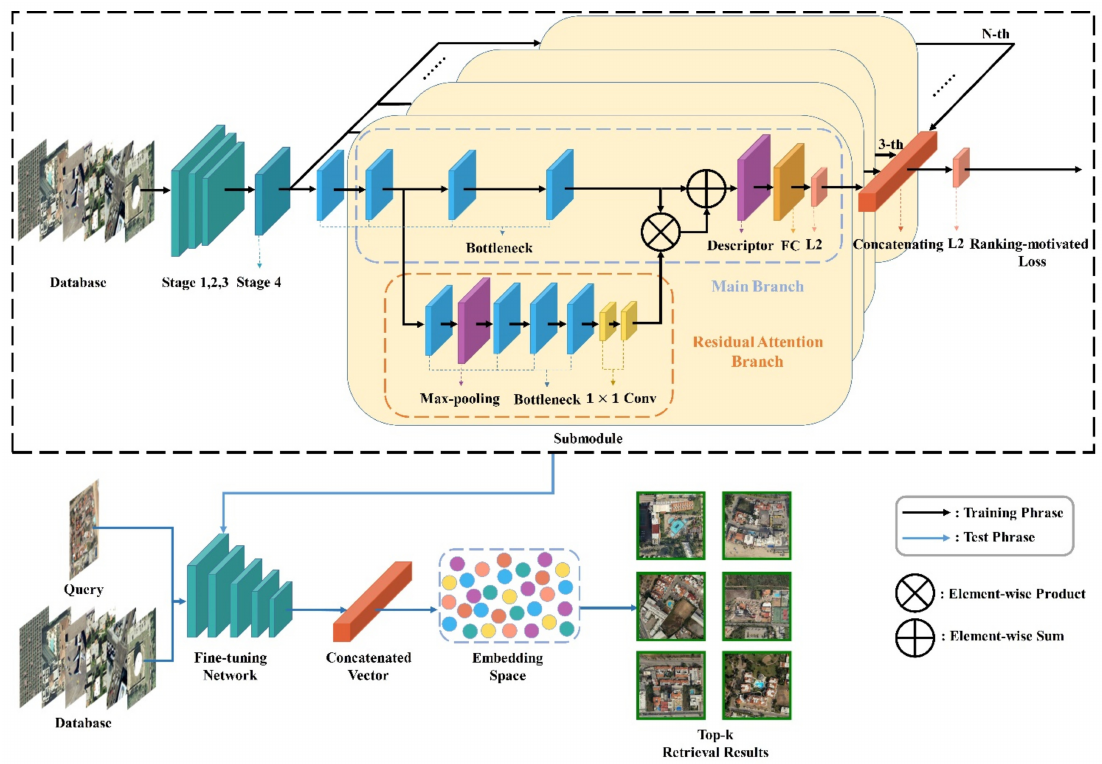
Figure 1. The overall architecture of EARA. The upper part framed by black dashed box is the training process of the network, and the bottom is the testing